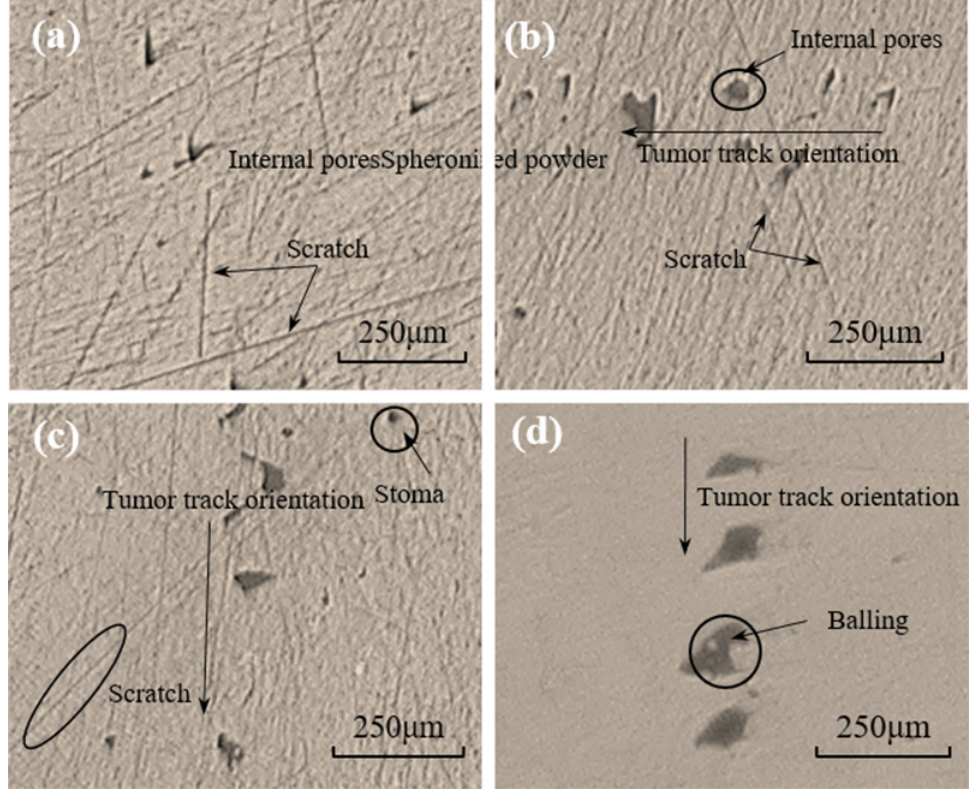
Fig. 5. Microscopic appearance under different abrasive particle sizes: (a) 20 m m, (b) 10 m m, (c) 5 m m, (d) 3 m